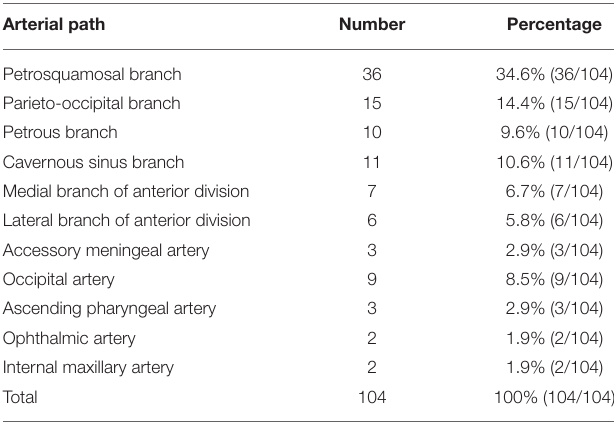
TABLE 5 | Arterial path used in the first EVT